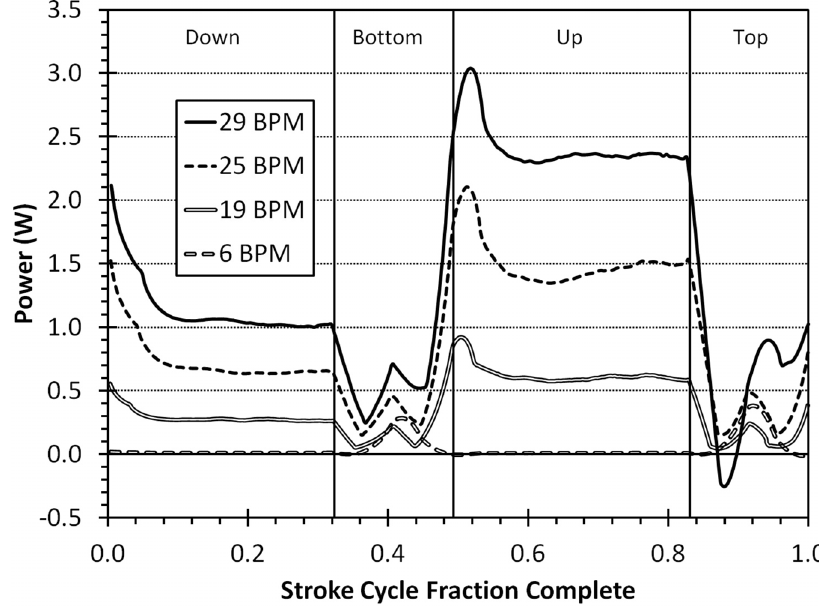
Figure 7. The power produced by our simulated juvenile turtles as they go through one stroke period. The vertical black lines demark the four different stroke phases (down, bottom, up, and top). Since each swimming frequency (beats per minute (BPM)) has its own period, the x-axis is percent of stroke completed.